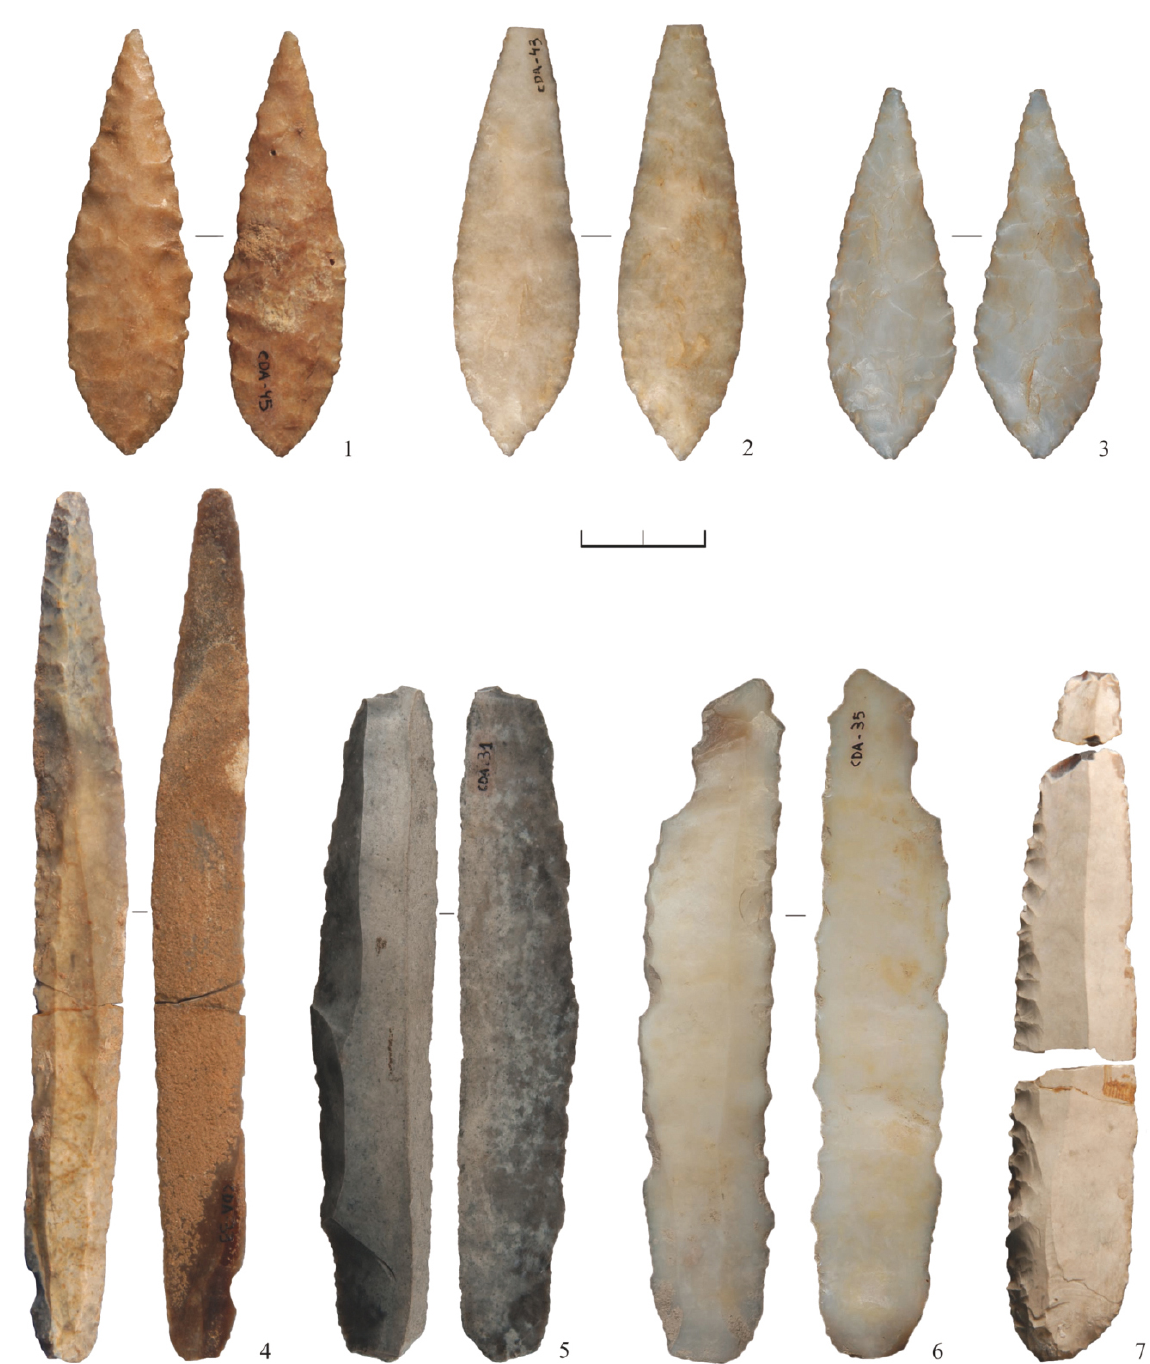
Figure 7. Part of the lithic set analysed from Cova de l’Avi. Scale bar = 2 cm (in 1 cm